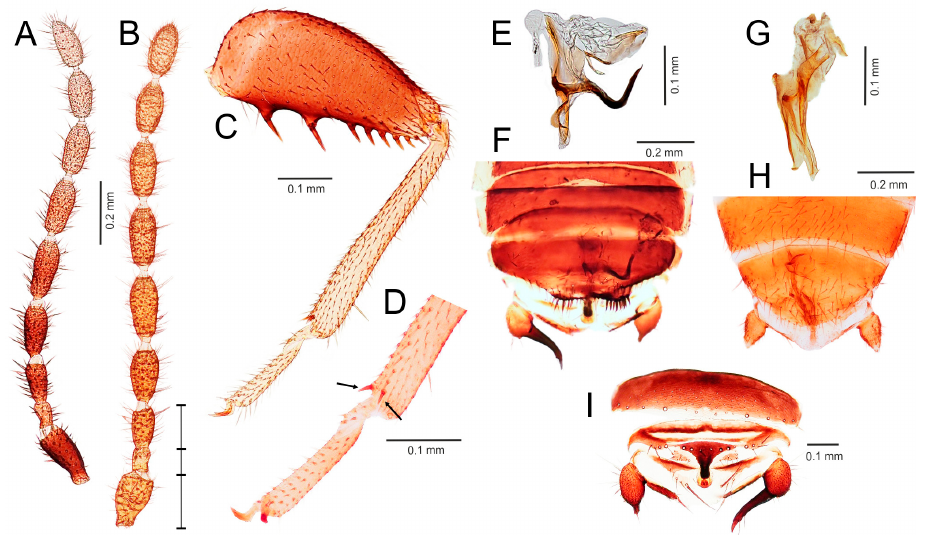
Figure 3. Morphological characters of Zorotypidae: Spermozorinae. ( A ) left antenna of Spermozoros asymmetricus , male, Brunei; ( B ) right antenna of S. weiweii with lengths of the three basal antennomeres indicated, male, Brunei; ( C ) right hind leg of S. asymmetricus , male, Brunei; ( D ) detail of right metatibia of S. asymmetricus , male, Brunei; ( E ) male genitalia of S. asymmetricus , ventral view, male Brunei; ( F ) ventral view of the apex of male abdomen of S. asymmetricus , Brunei; ( G ) male genitalia of S. weiweii , ventral view, Brunei; ( H ) ventral view of the apex of male abdomen of S. weiweii , Brunei; and ( I ) dorsal view of the apex of male abdomen of S. asymmetricus , Brunei.